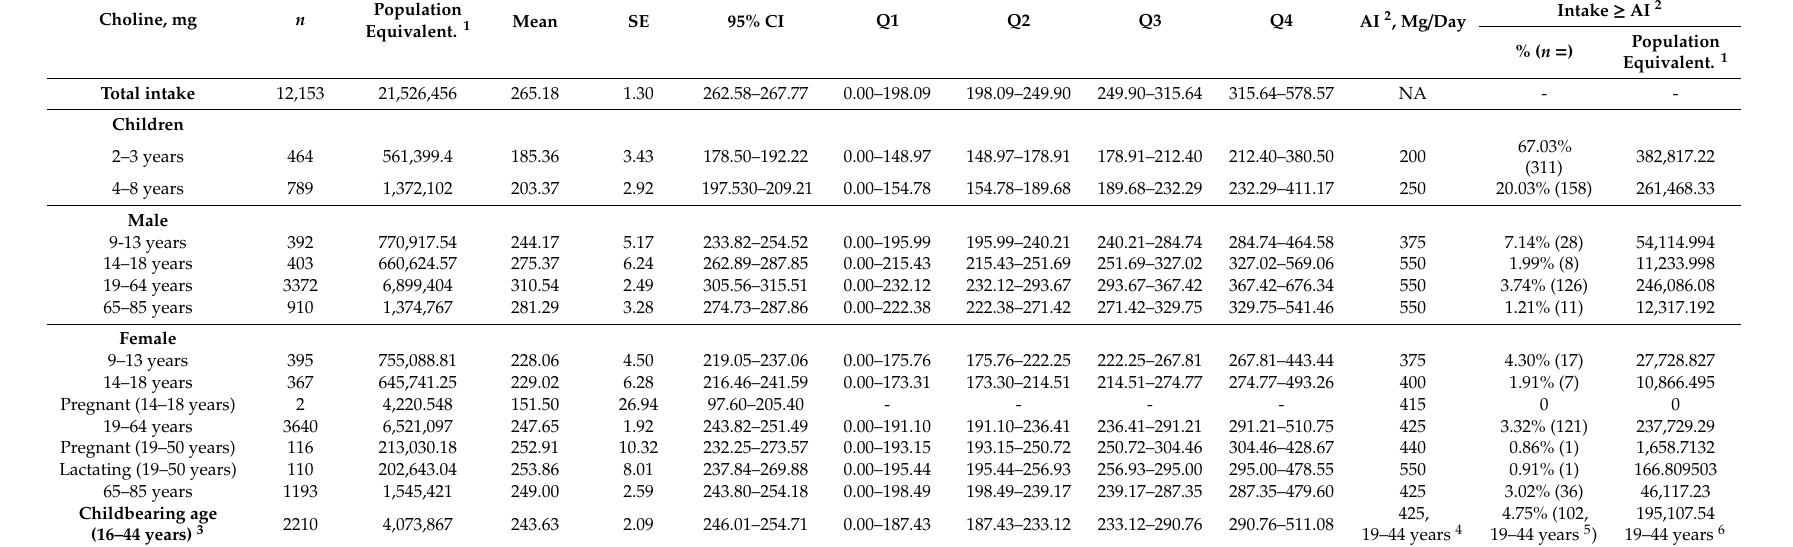
Table 1. Choline intakes for the Australian population ( n = 12153) by